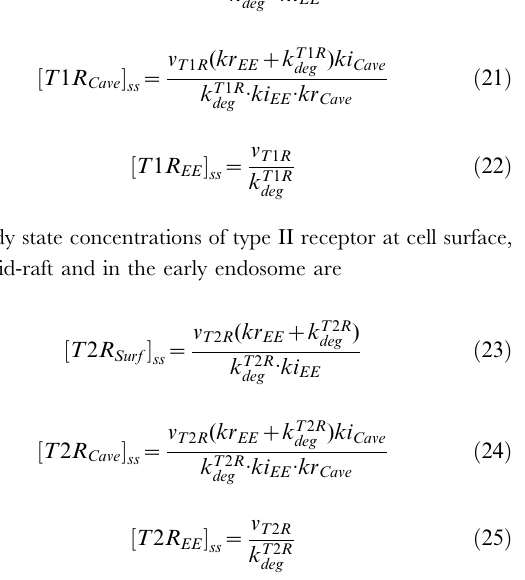
Smad: Figure 3 of reference [22] shows that nuclear import rate between phoshporylated and unphosphorylated Smad2 is similar. Therefore, we set the import rate constant for the phosphorylated Smad complex ( k Smads_Complex imp ) to the same value as the import rate constant for unphosphorylated Smad2, which is 0.16 min 2 1